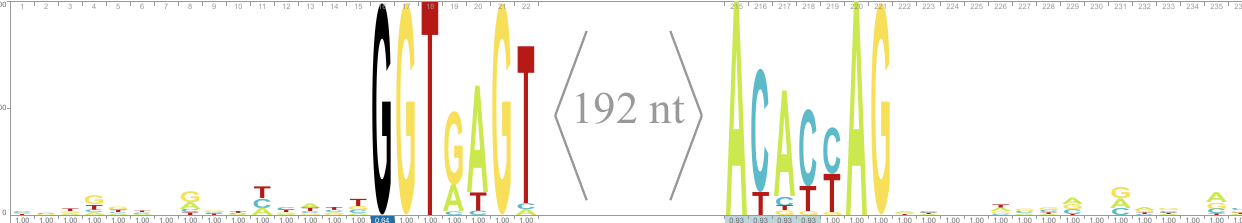
Table S1: sheet CO27-5). A total of 7 of the 33 sister (stw)introns (~20%) occur in